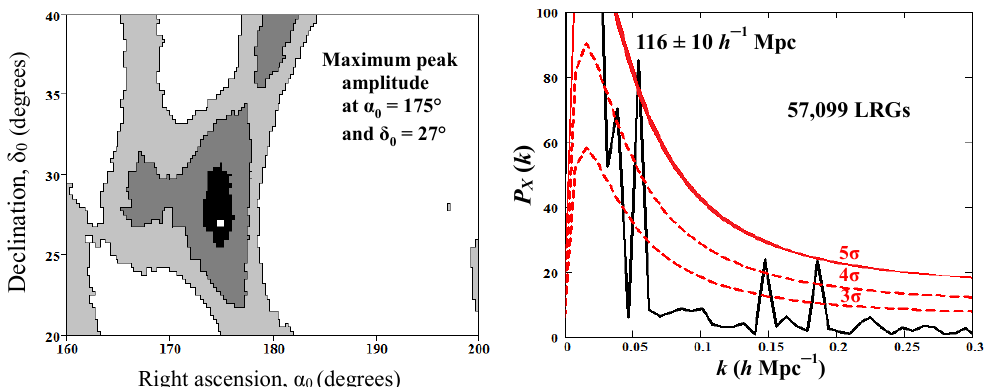
Figure 4. Same as the left and right panels of Figure 3, respectively, but for all of the data of the rectangle region shown in Figure 1. The maximum peak direction ( α 0 and δ 0 ) practically coincides (slightly differs) with that in Figure 3 (see Table